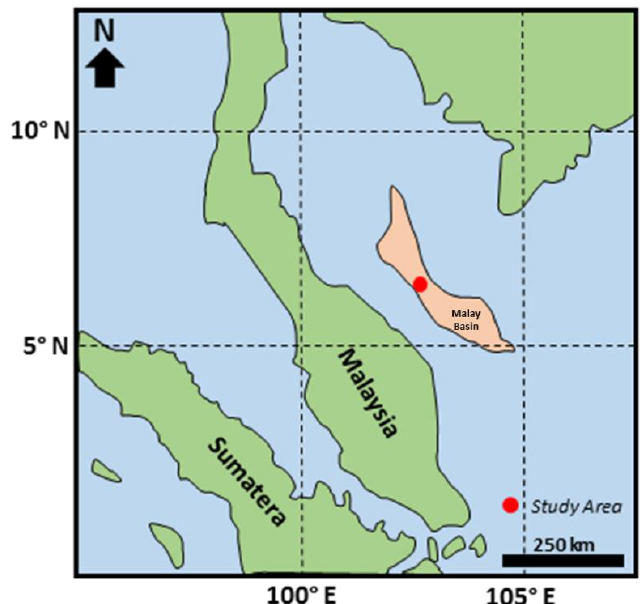
Figure 1. Geographical map of Peninsular Malaysia. The red circle is the study area location which is located in the Malay Basin.